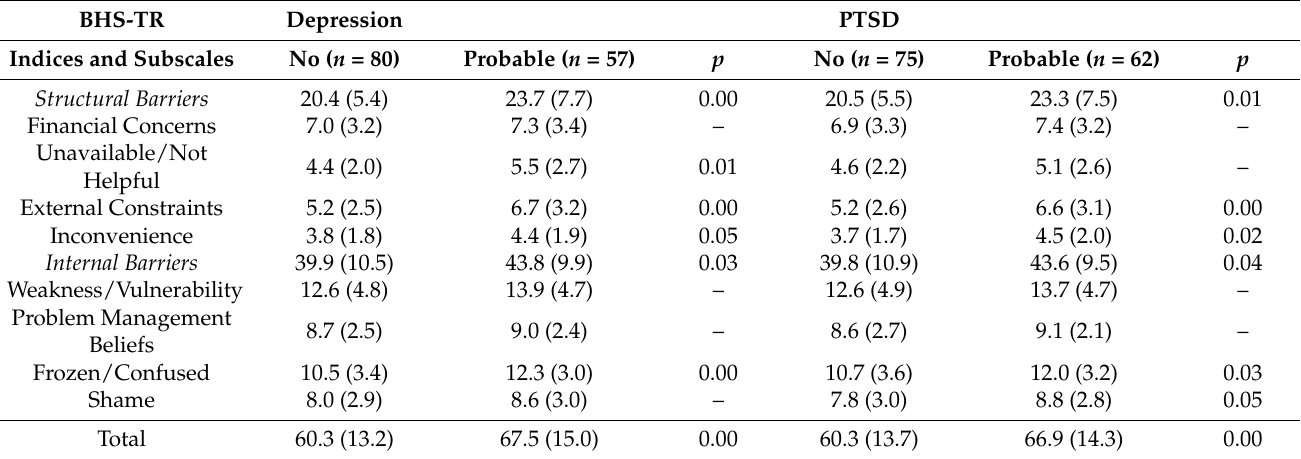
Table 7. Known-groups validity results.